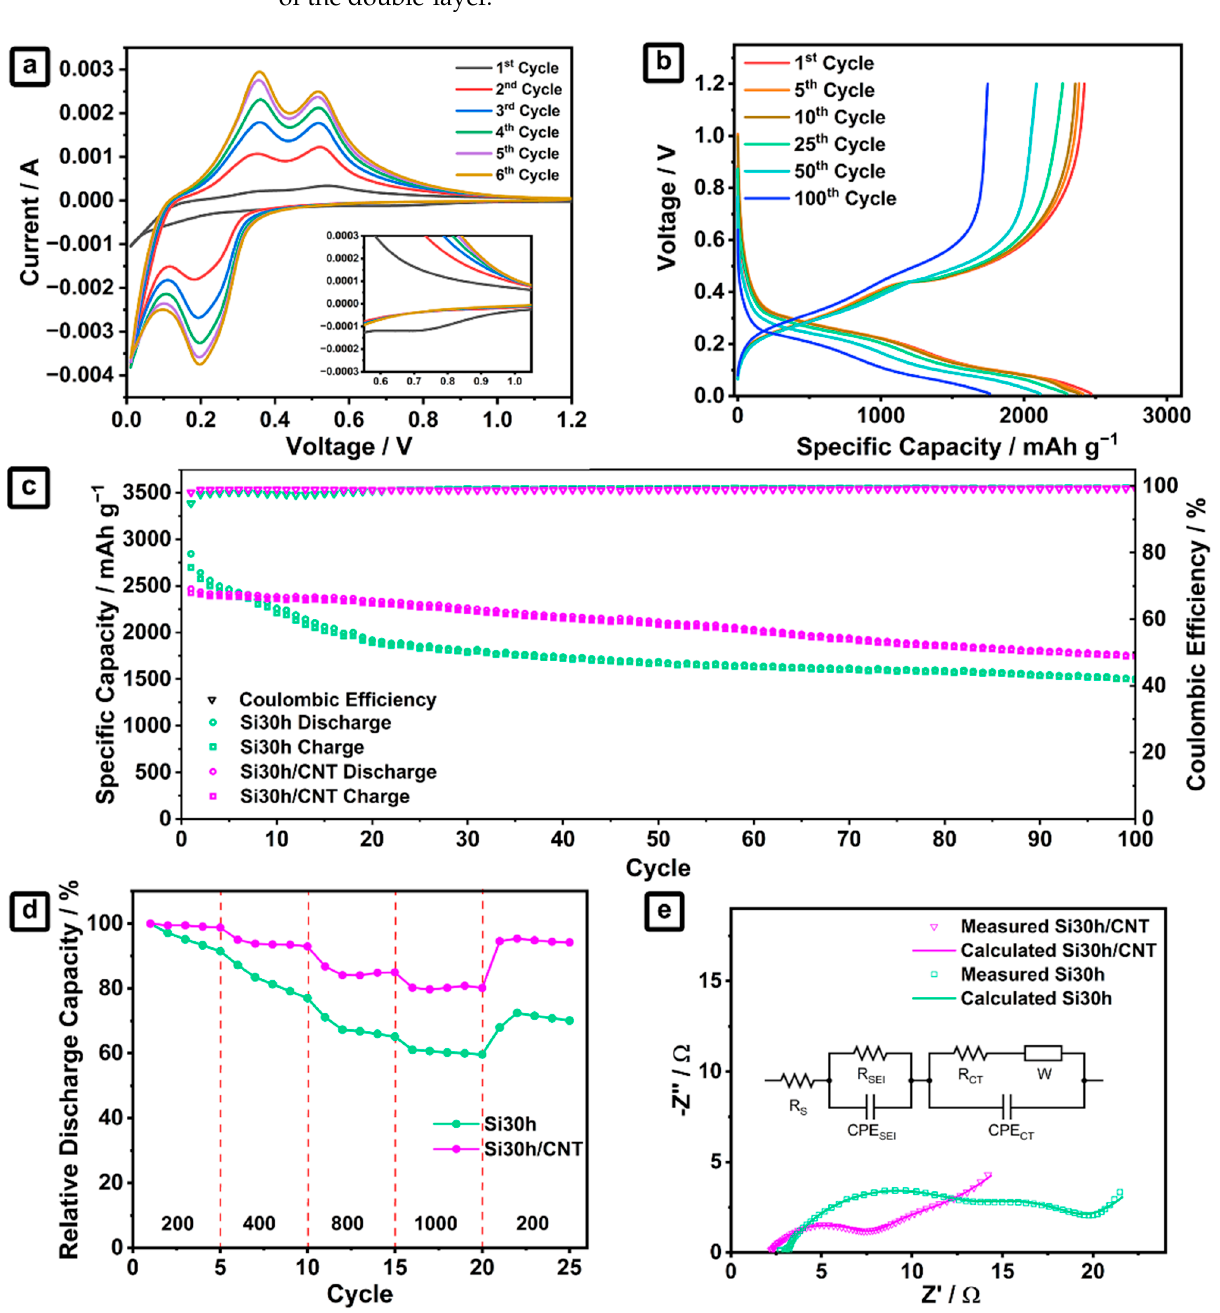
Figure 5. ( a ) Cyclic voltammograms (CVs) and ( b ) charge/discharge profiles of the cell with the Si30h/CNT electrode. ( c ) Cycling performance, ( d ) rate performance, and ( e ) Nyquist plot with the fitted equivalent circuit of the cells with Si30h and Si30h/CNT electrodes.